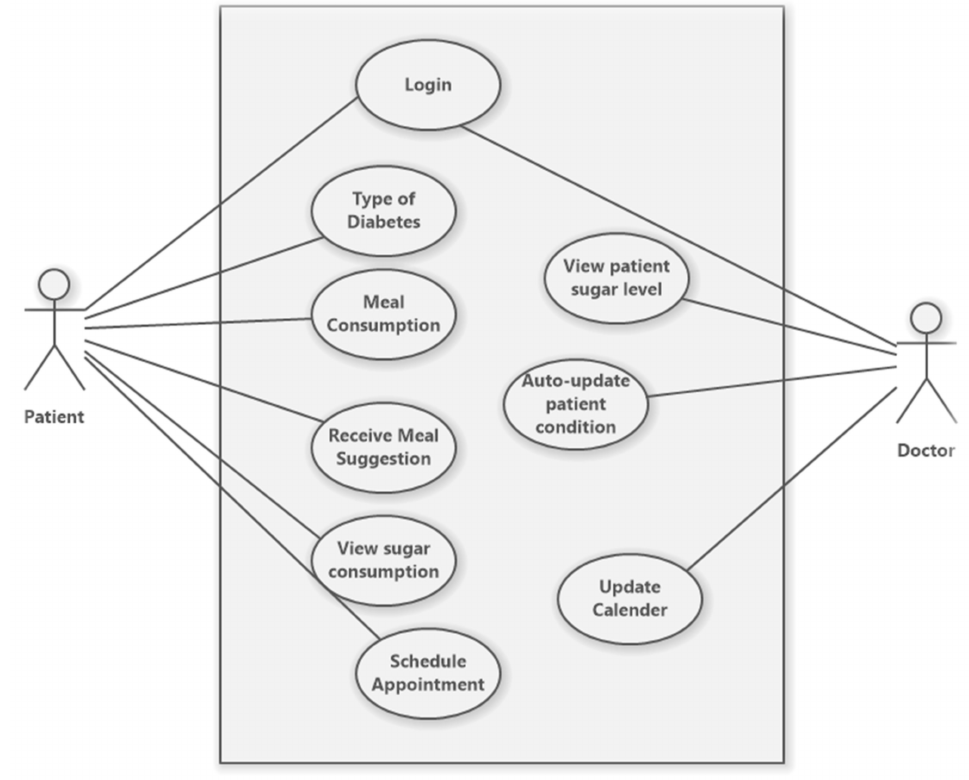
Figure 1. Use case diagram for diabetes telehealth